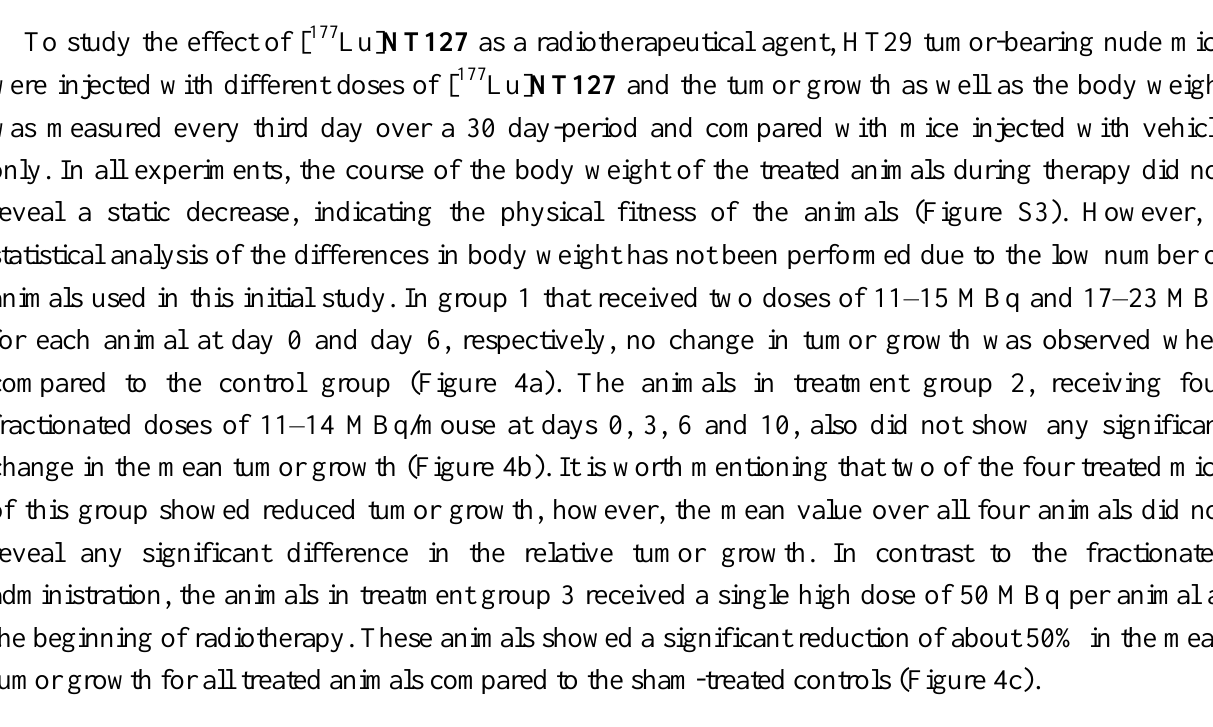
Figure 4. (a,b,c) Change in tumor growth after a single high (c) dose or a two-time (a) or four-time (b) sequential dose of [ 177 Lu] NT127 . (d,e,f) Standard uptake values (SUVmean) of [ 68 Ga]DOTA-RGD in HT29 tumor-bearing nude mice at day 7, 14, 21 and 28 after injection of a single (f) ; two-time (d) ; or four-time (e) dose of [ 177 Lu] NT127 . * p < 0.05, n = 8 (sham-treated animals) vs. n = 3 (treated